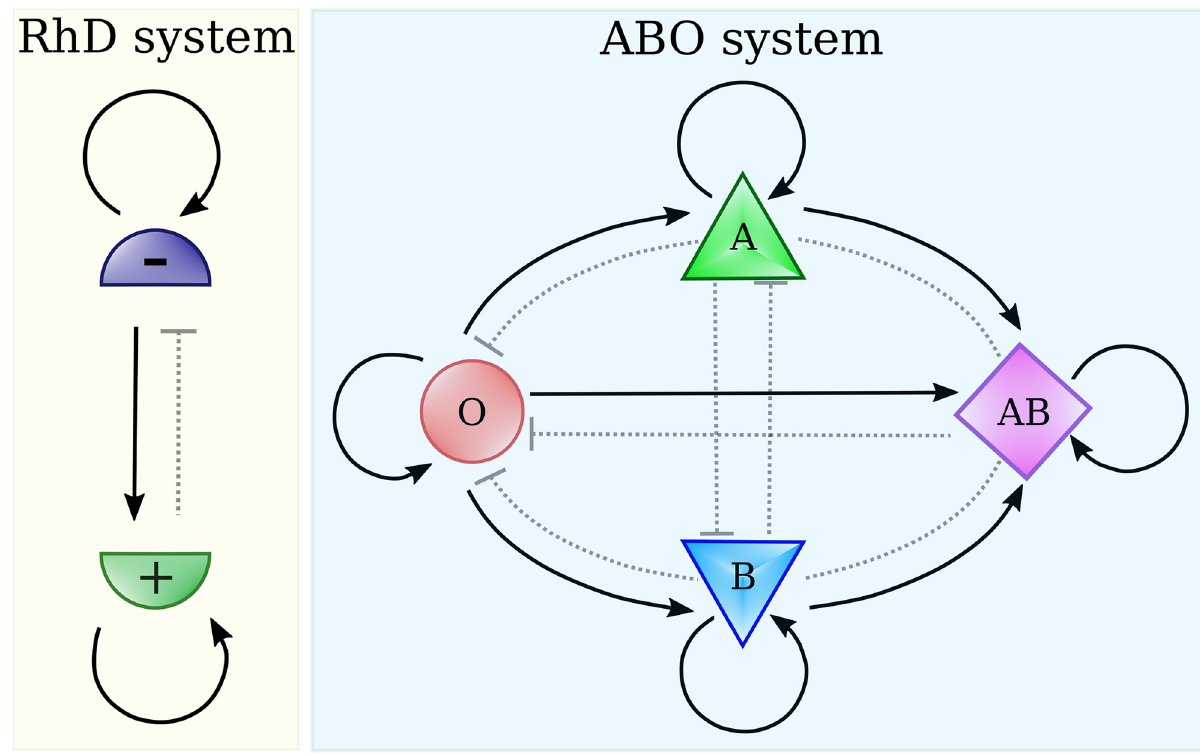
Fig 1. Scheme of the possible infection rules according to RhD blood types and ABO ones. Full line connection indicated the possibility of infection, W ij = 1, while dotted connection its impossibility. In the RhD infection system, individuals of the same group can infect each other, people with the RhD- group can transmit the infection to people with RhD+ one, but not viceversa . The scenario of the ABO system is similar although richer. For instance, the O type can infect the A type, while the opposite is not